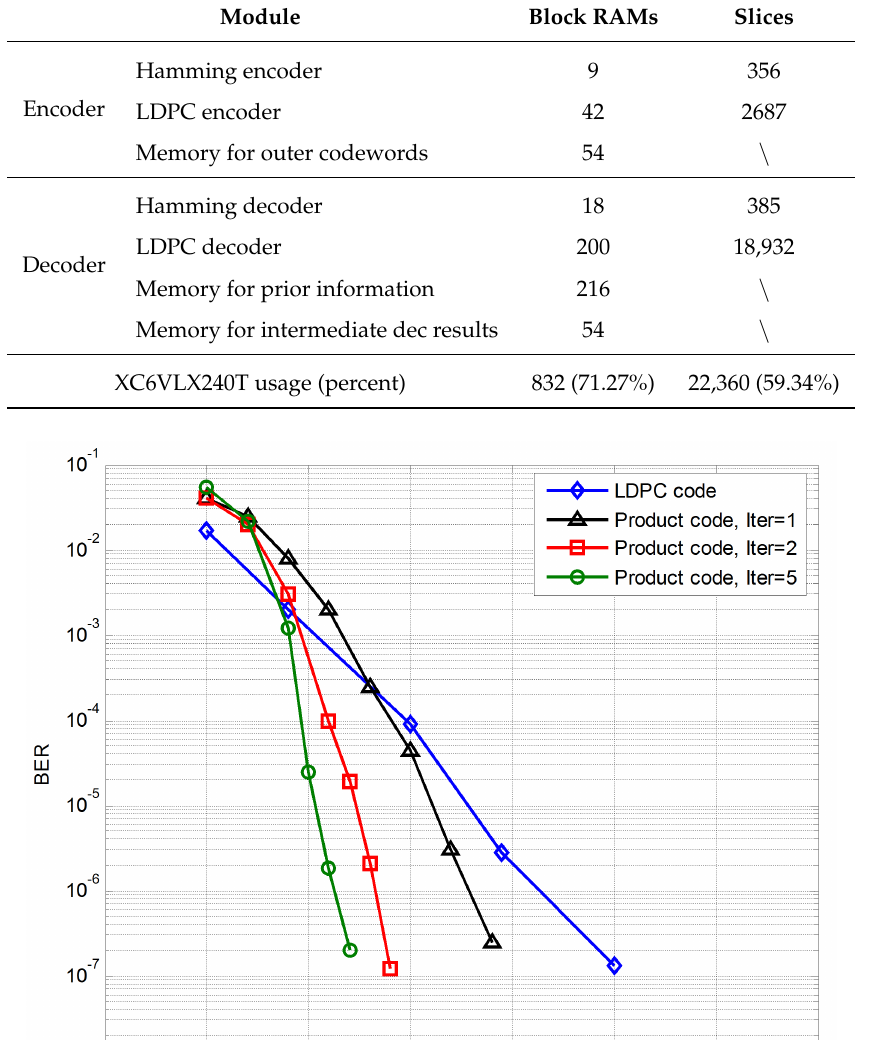
Table 2. The resource usage of hardware evaluation platform.